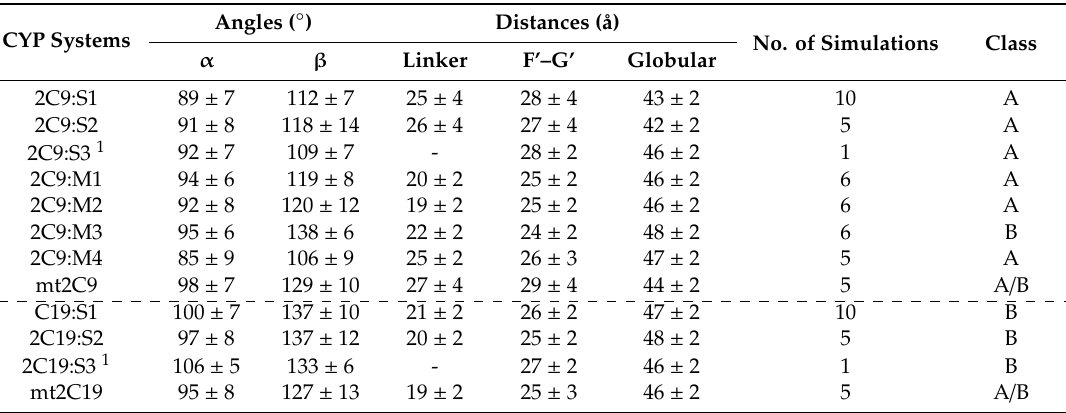
Table 1. Results of CG simulations of CYP 2C9 and CYP 2C19 for the full length (S1, S2) and truncated (S3) wild-type proteins (based on crystal structures 1R9O and 4GQS, respectively), various models of full length CYP 2C9 (M1–M4, based on structures Model 1–4), and the mutant chimeras, mt2C9